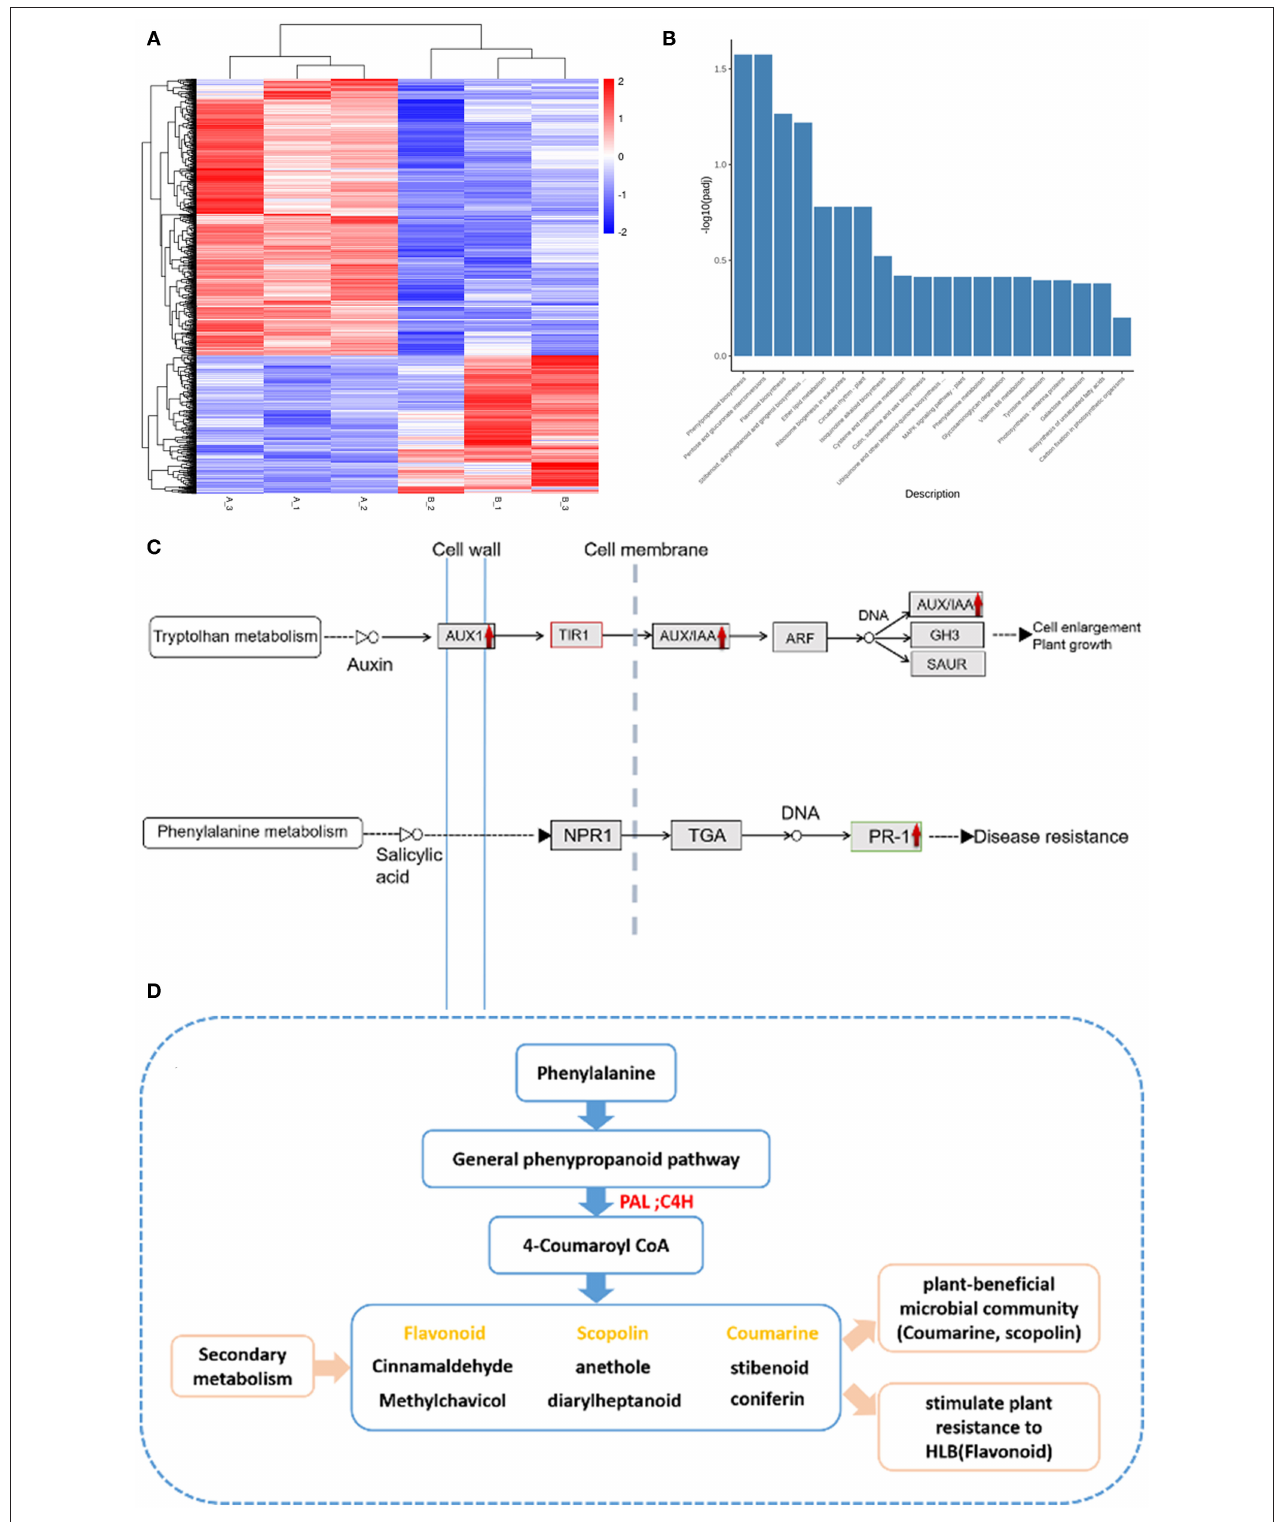
FIGURE 7 | Transcriptome experiments data analysis. (A) Expression profiles of DEGs between pre-treatment and post-treatment. Heat map for cluster analysis of DEGs by K-means method. Red indicates up-regulated and blue indicates down-regulated, comparison is (B) vs. (A) . 1,050 genes were up-regulated, and 527 genes were down-regulated as a consequence of treatment. (B) The KEGG enrichment. The most significant 20 KEGG pathways were selected for the histogram.